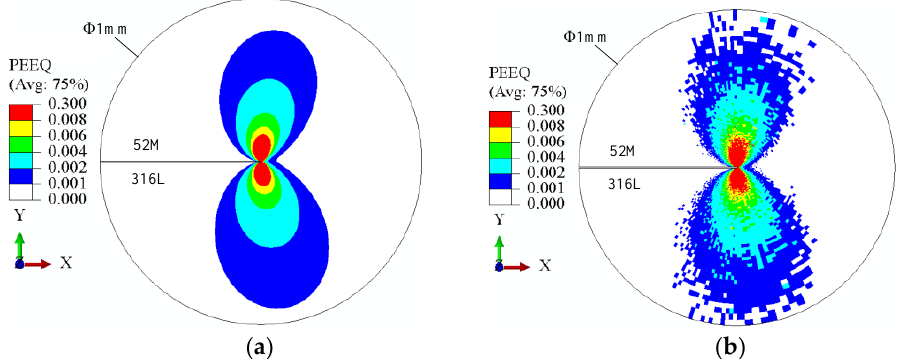
Figure 14. Equivalent plastic strain at the tip of crack 2: ( a ) homogeneous; ( b ) inhomogeneous.